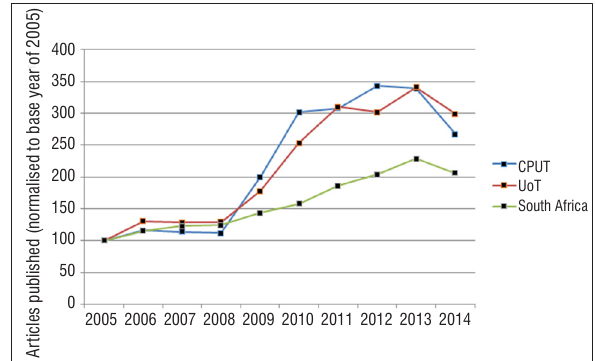
Figure 1: Growth in research output over a ten-year period. Visibility